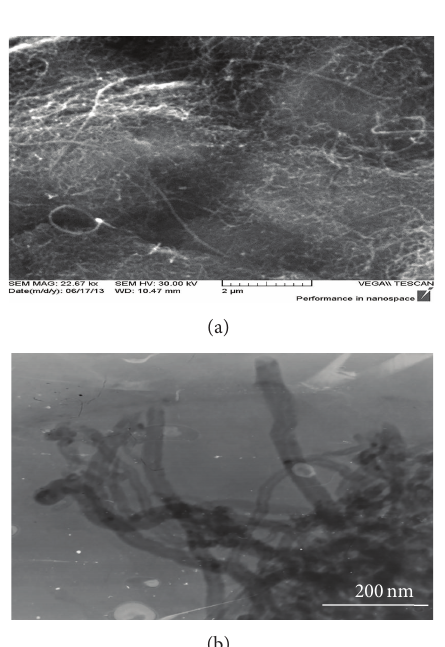
Figure 3: (a) SEM image of the prepared CNTs. (b) TEM image of the prepared CNTs.